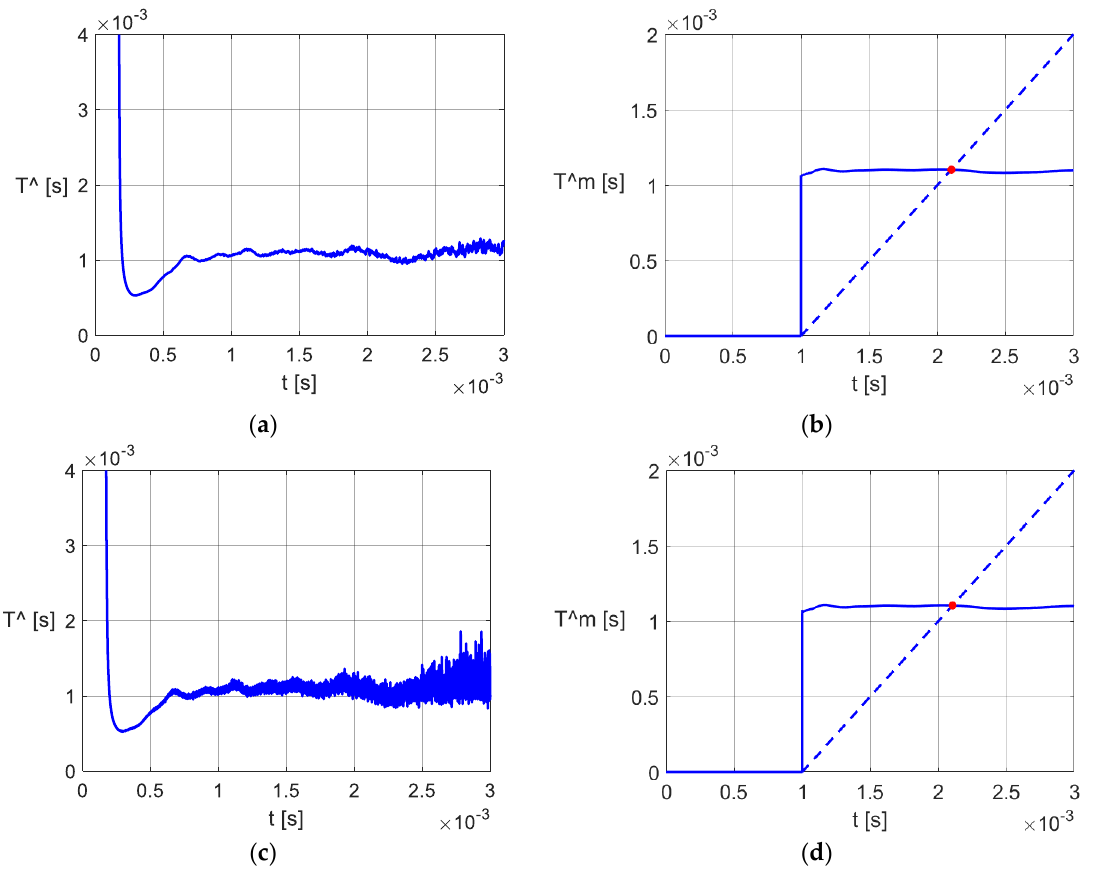
Figure 16. Variations 𝑇̂(𝑡) and 𝑇̂ 𝑚 (𝑡) calculated with the discrete-time PO for the second stage of discharge of 100 µF in Figure 14b: ( a , b ) the results calculated using filtered data; ( c , d ) results calculated using unfiltered data.